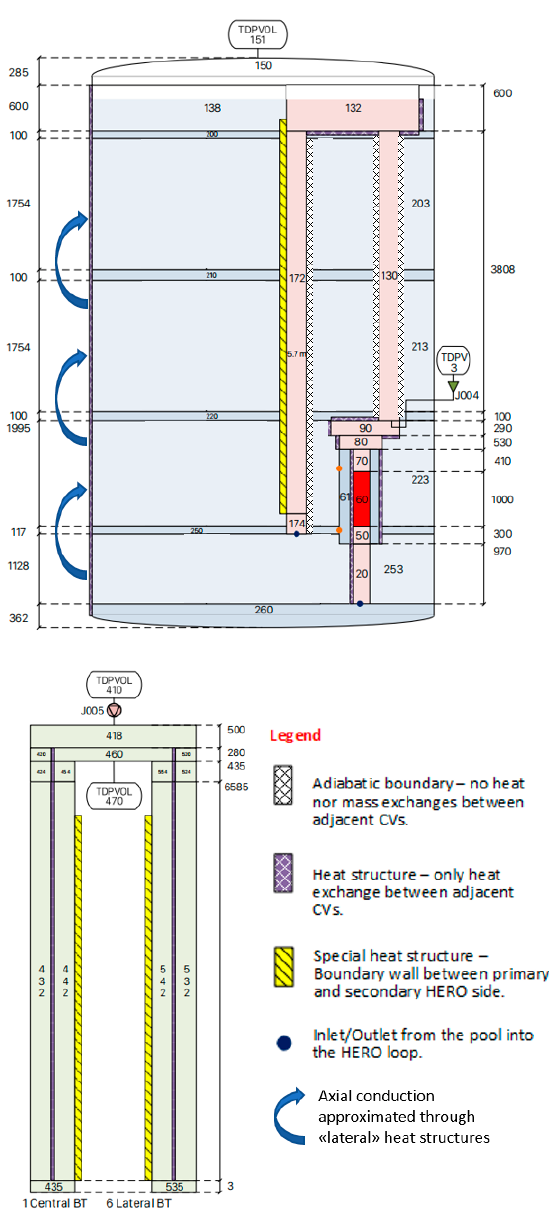
Figure 5. Nodalization of CIRColazione Eutettico—Heavy liquid mEtal pRessurized water cOoled tubes (CIRCE-HERO).